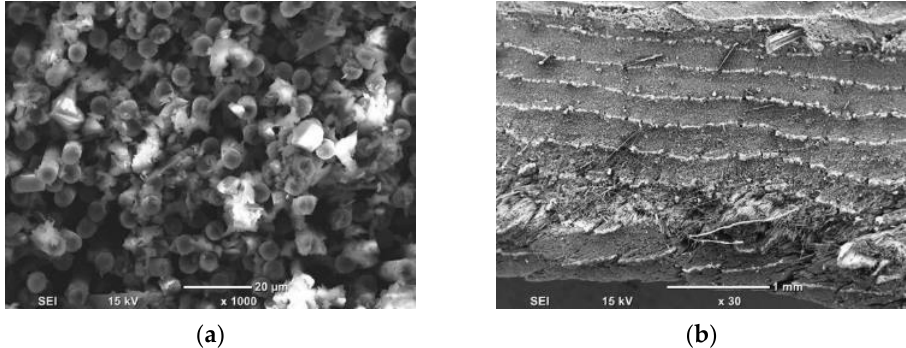
Figure 19. SEM images of machined surfaces for ( a ) Experiment 31 ( θ = 135°, α = 10°); and ( b ) Experiment 34 ( θ = 135°, α = 30°), with machining direction from left to right.